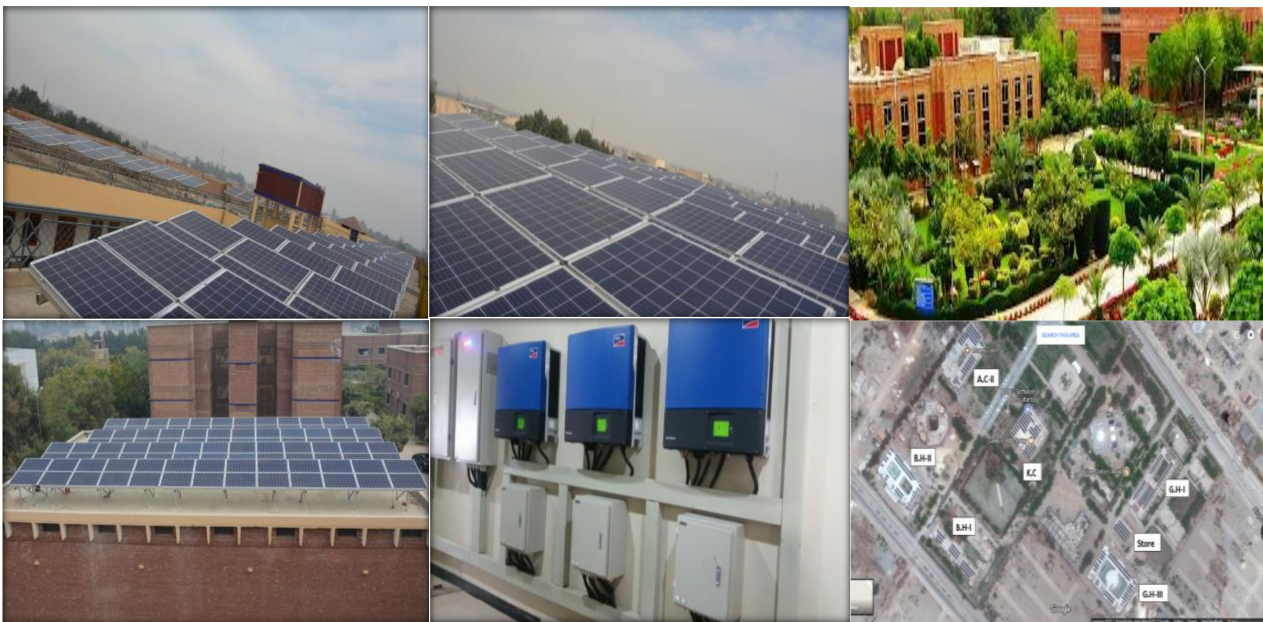
Figure 3. Green university.